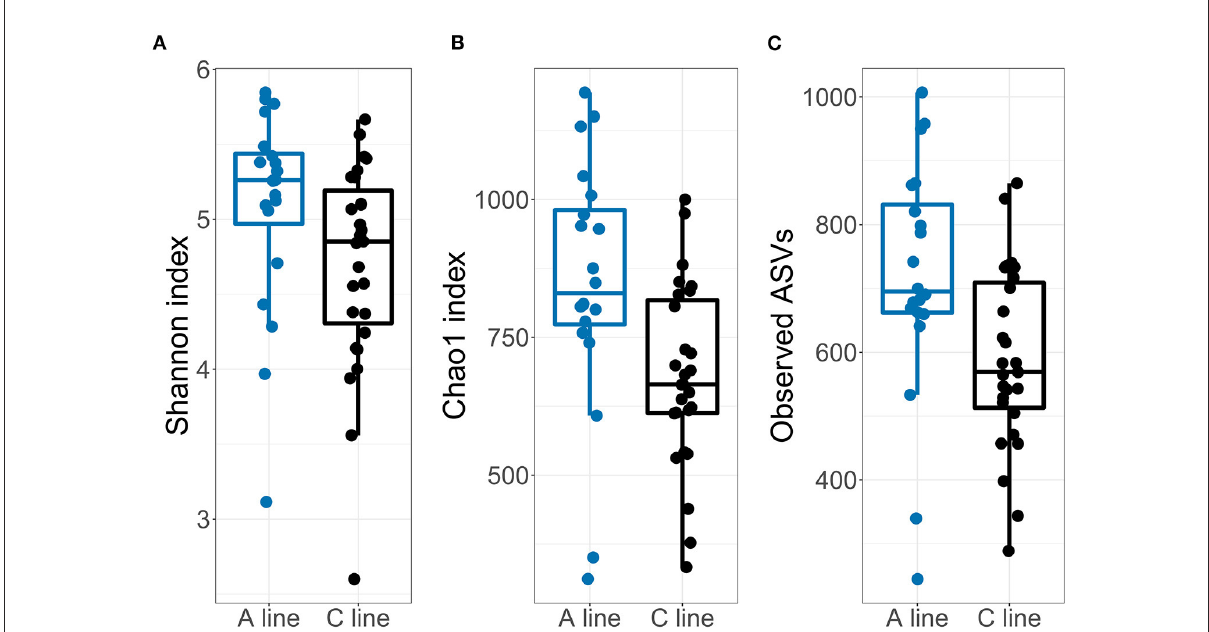
FIGURE6 Diversities of the gut microbiotas of the offspring bank voles born during the field experiment for (A) Shannon index, (B) Observed ASV count and (C) Chao1 index. Dots represent individual samples (A line, blue; C line, black).